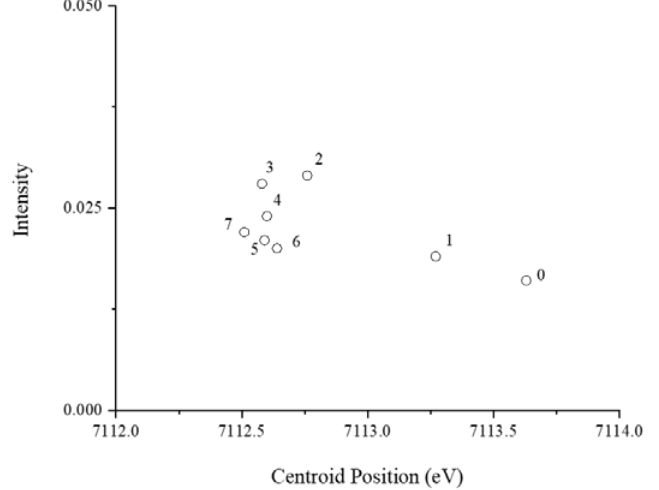
Figure 2. Pre-edge peak centroid energies and integrated pre-edge intensities obtained from the analysis of the X-ray absorption near-edge structure (XANES) region. Samples were collected daily (from day 0 to day 7) from culture filtrates of P. involutus growing on BSA-containing medium.